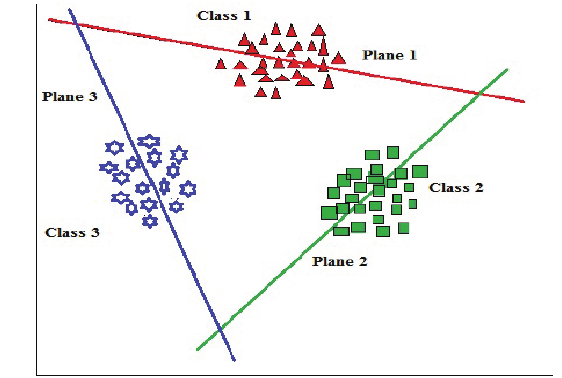
Fig. 1. Geometric representation of Linear